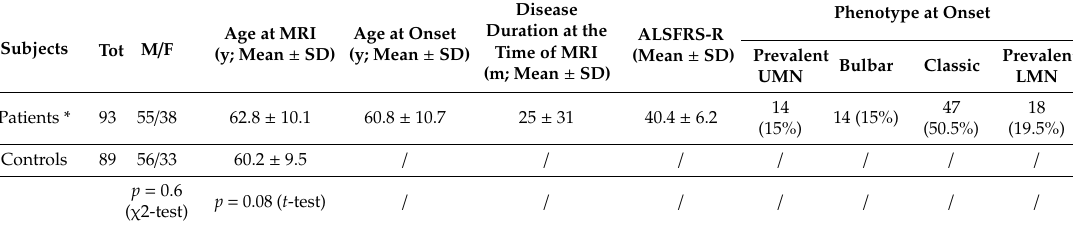
Table 1. Characteristics of study